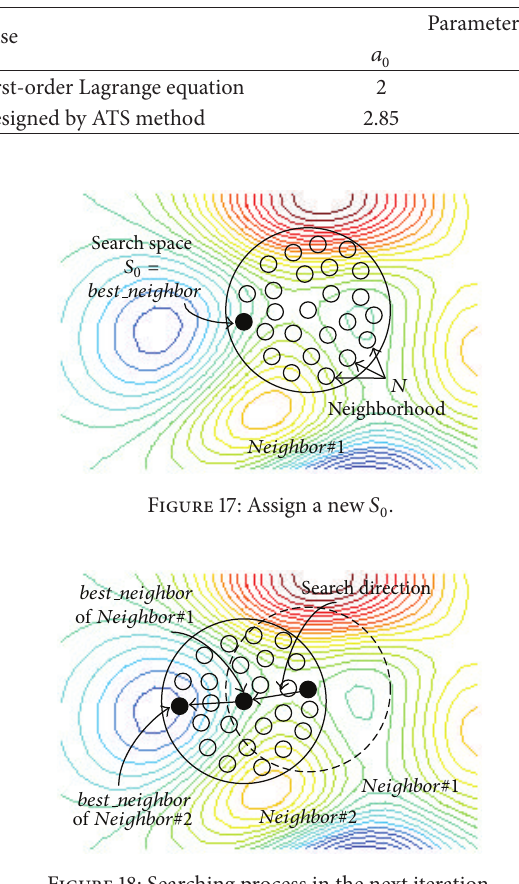
Figure 18: Searching process in the next iteration.